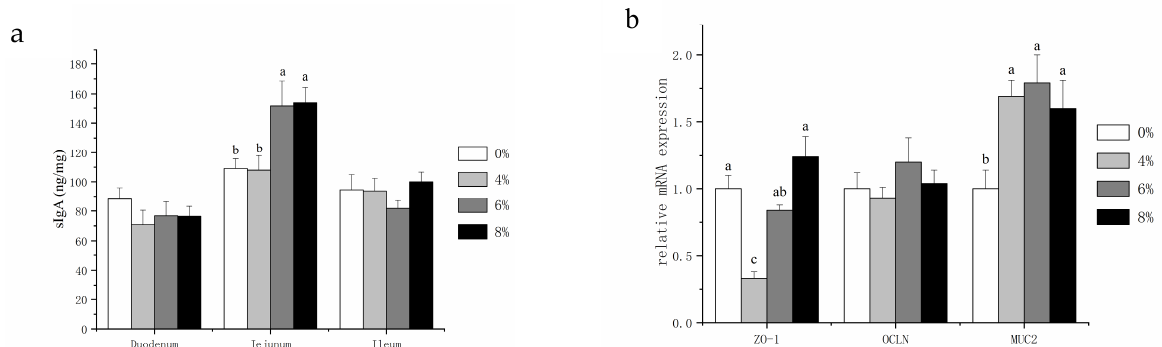
Figure 2. Effects of fermented mixture supplementation on the intestinal sIgA content ( a ) and the physical barrier in the jejunum ( b ) of laying hens. Data are expressed as mean ± SEM of 6 replicates per treatment; a–c There are statistically significant differences in the mean values per line for different superscripts ( p < 0.05).